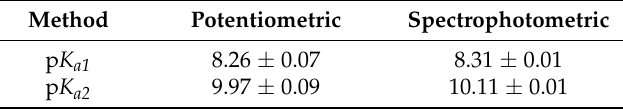
Table 1. p K a values of m -phenylenediboronic acid.